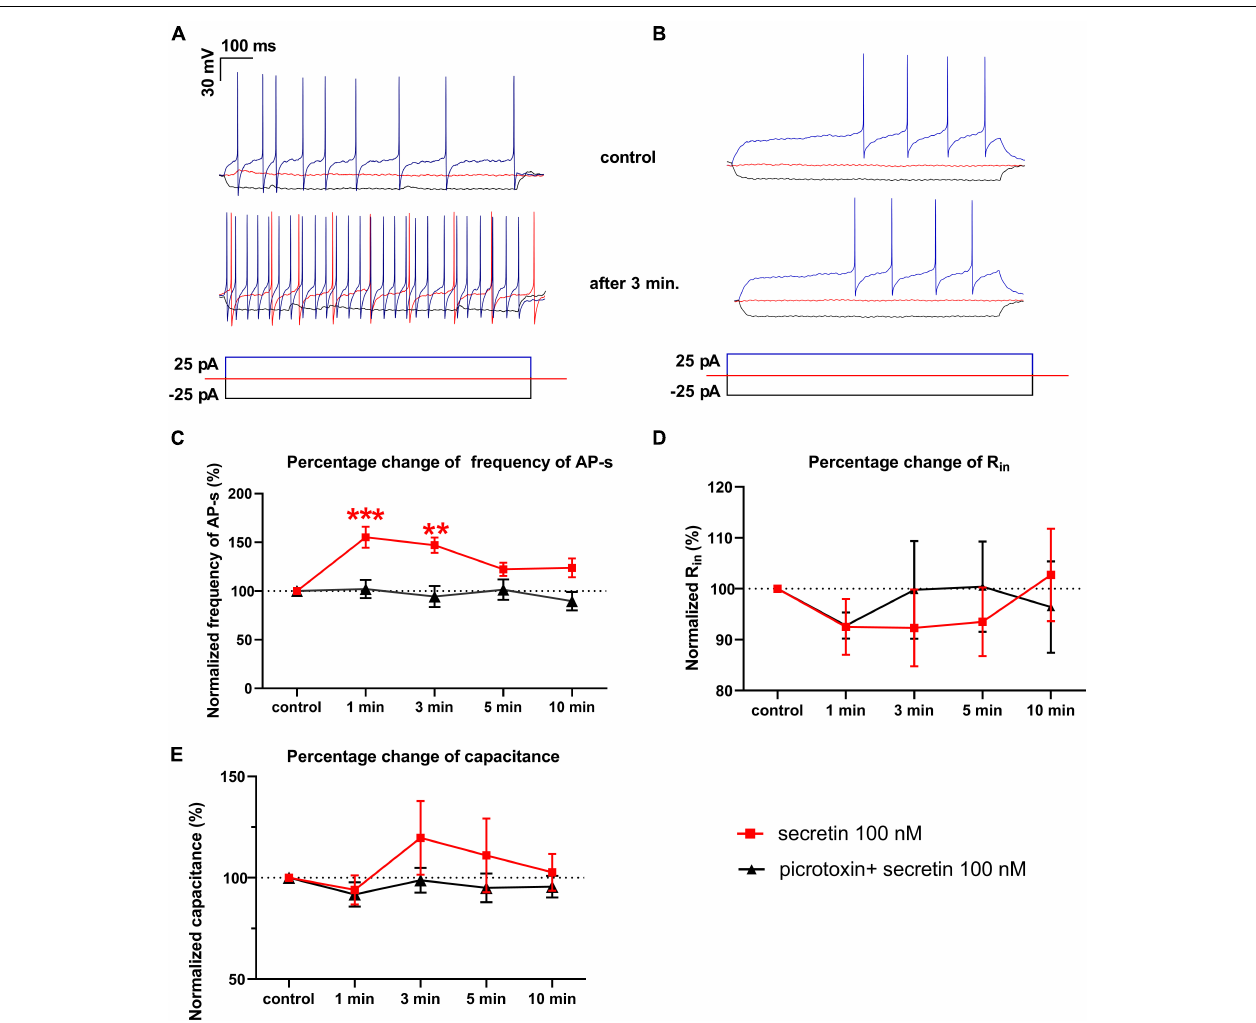
FIGURE 2 | Secretin (100 nM) increases the frequency of the evoked APs. (A) Representative recording shows that frequency of APs evoked by depolarizing current steps elevated 3 min after secretin administration. Also, the rheobase of APs decreased after secretin treatment. There was no change in the average amplitudes of APs. (B) Representative recording of the effect of secretin in the presence of picrotoxin (C) Secretin results in a significant rise in the frequency of APs after 1 and 3 min of its administration (marked by red (cid:4) ) in the presence of picrotoxin there was no significant change (marked by (cid:78) ). (D) Changes in the R in represented no significant alteration. (E) Membrane capacitance also showed no significant change. ( ∗∗ p < 0.01; ∗∗∗ p < 0.001).